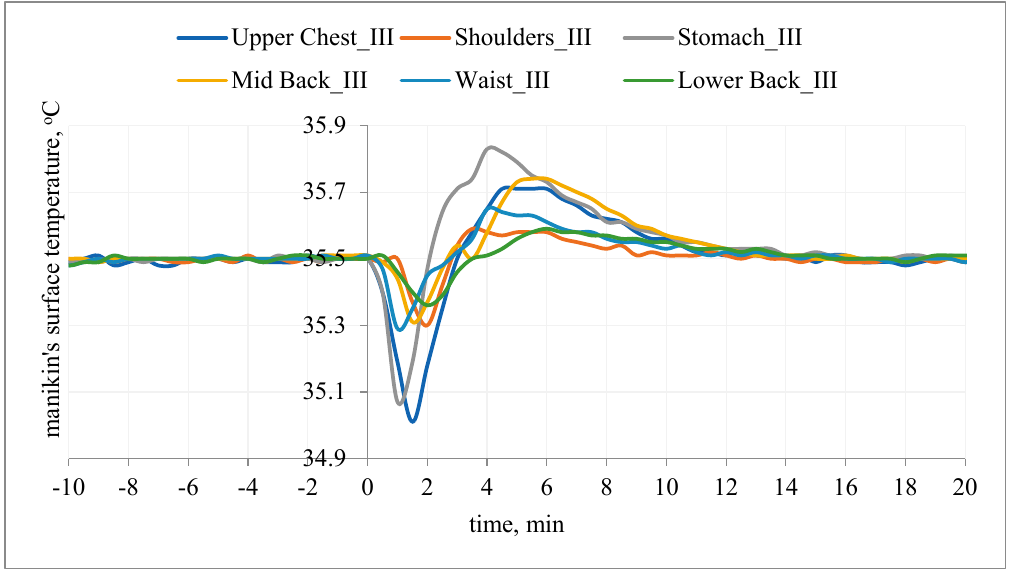
Figure 14. The surface temperature of the manikin after application of T-shirt A without PCM under the outer clothing (variant III).